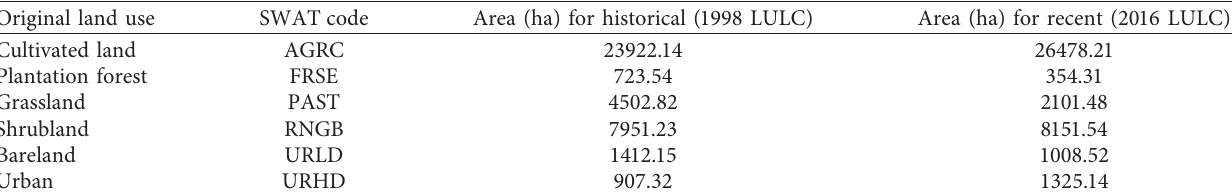
Table 4: Land use/land cover as reclassified by